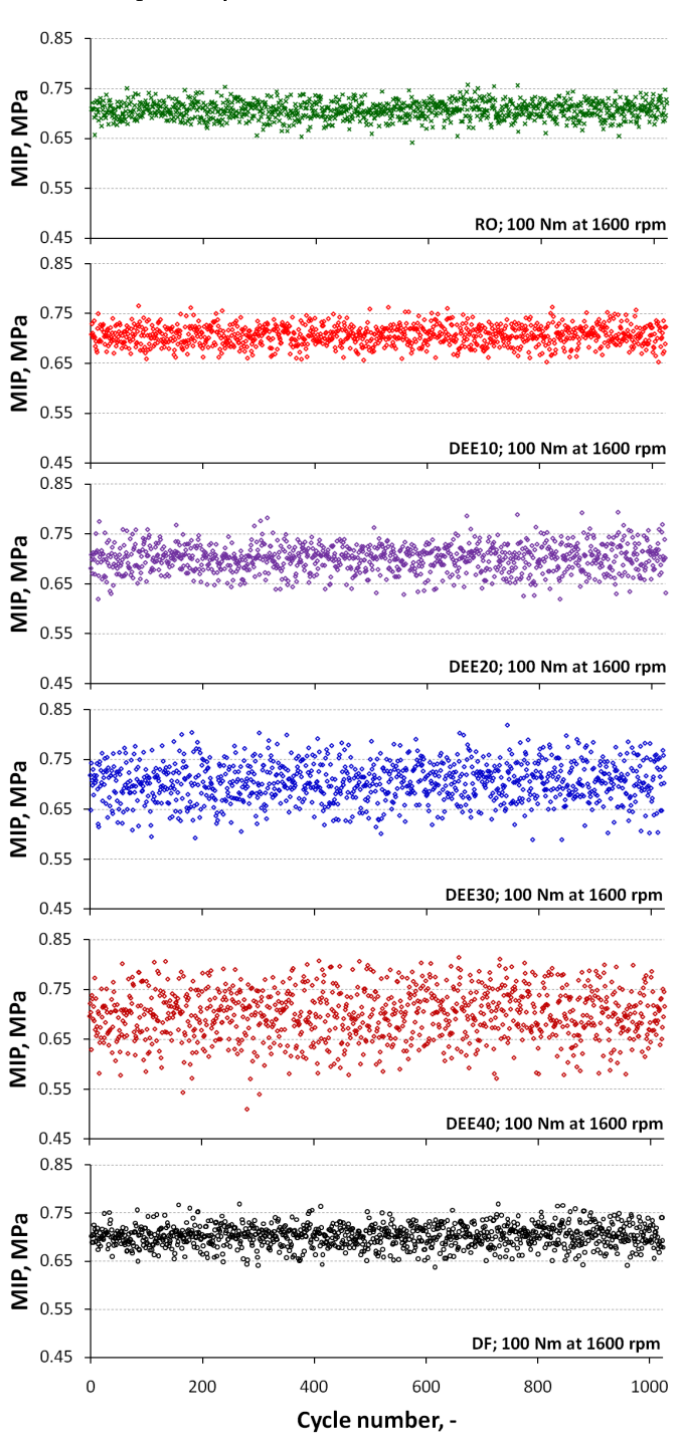
Figure 5. MIP calculated for 1024 consecutive cycles recorded for the AD3.152 engine fueled with tested fuels, operated with 100 Nm at 1600 rpm.